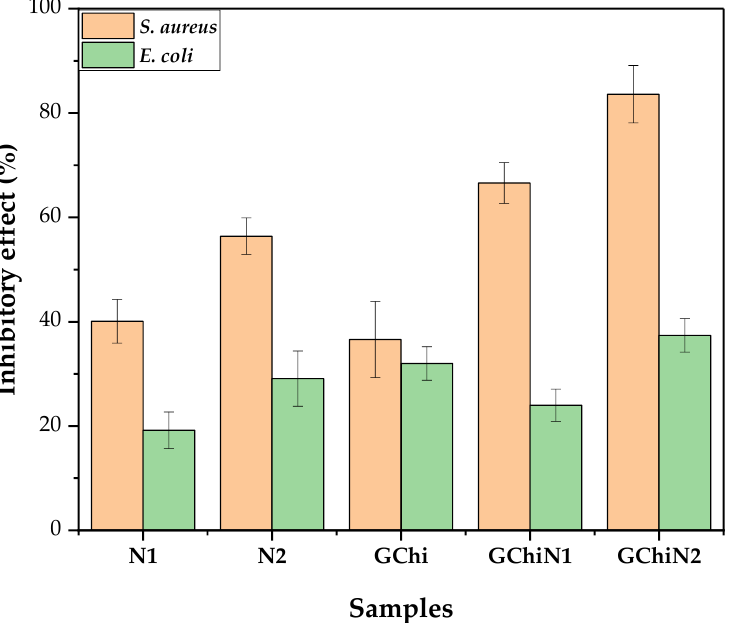
Figure 4. Antibacterial activity of GChi, N1, N2, GChiN1, and GChiN2 against Staphylococcus aureus (ATCC 25,923) and Escherichia coli (ATCC 10536).